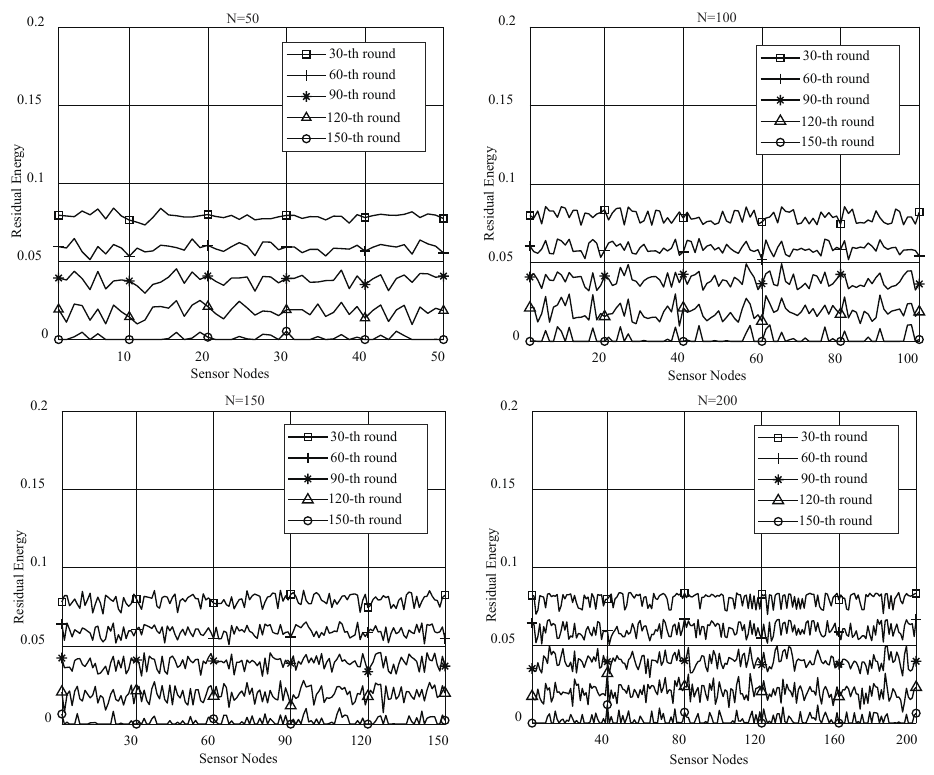
Figure 7. Residual energies of sensor nodes in different